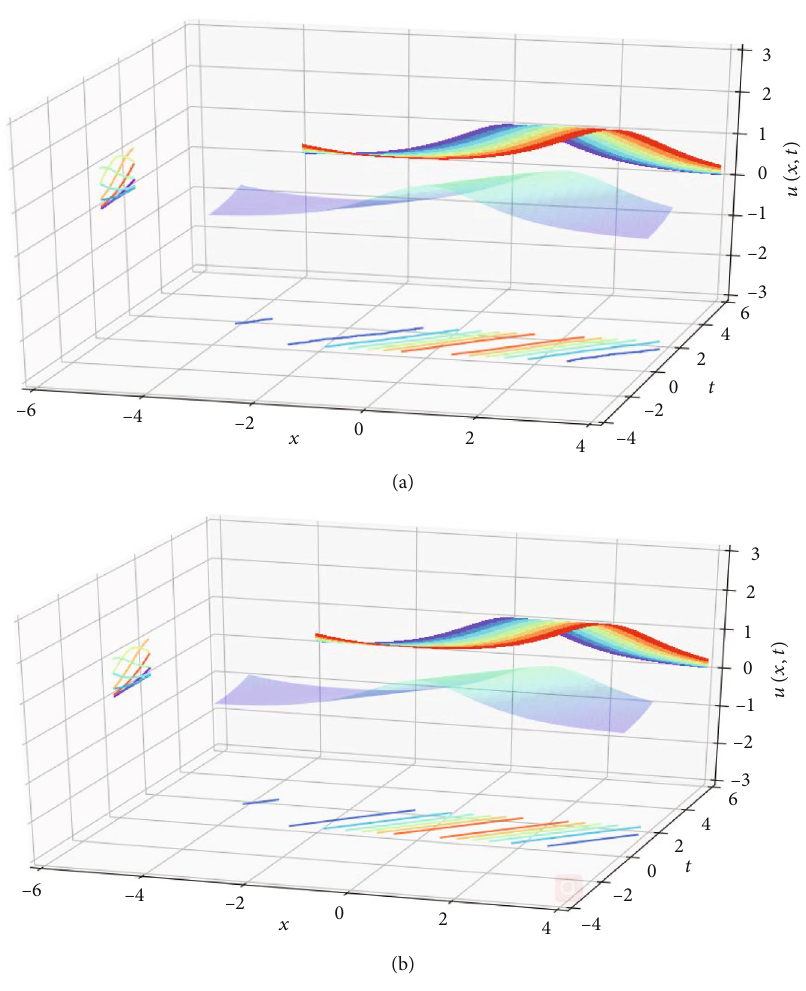
Figure 4: The projection of the exact solution (a) in the x − t , x − u , t − u direction and the projection of the predicted solution (b) in the x − t , x − u , t − u direction of the mkdv equation with initial state u ð x , 0 Þ = 2 sech ð 2 x Þ .